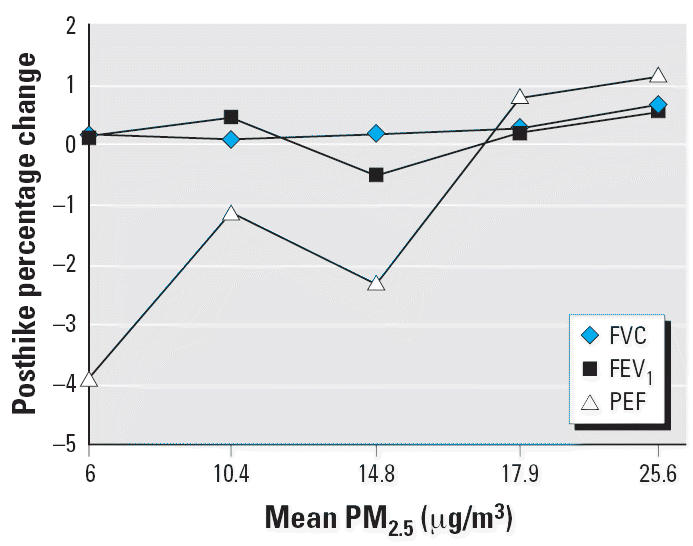
Hikers’ mean posthike percentage change in FVC, FEV1, and PEF as a function of quintile of PM2.5 concentration.